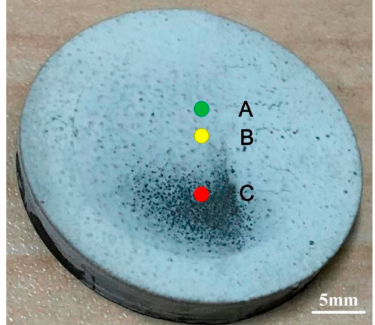
Figure 5. Photograph of the thermal barrier coating sample after artificial erosion. Spots A, B, and C has undergone increasing degrees of erosion and were scanned using THz reflection spectroscopy